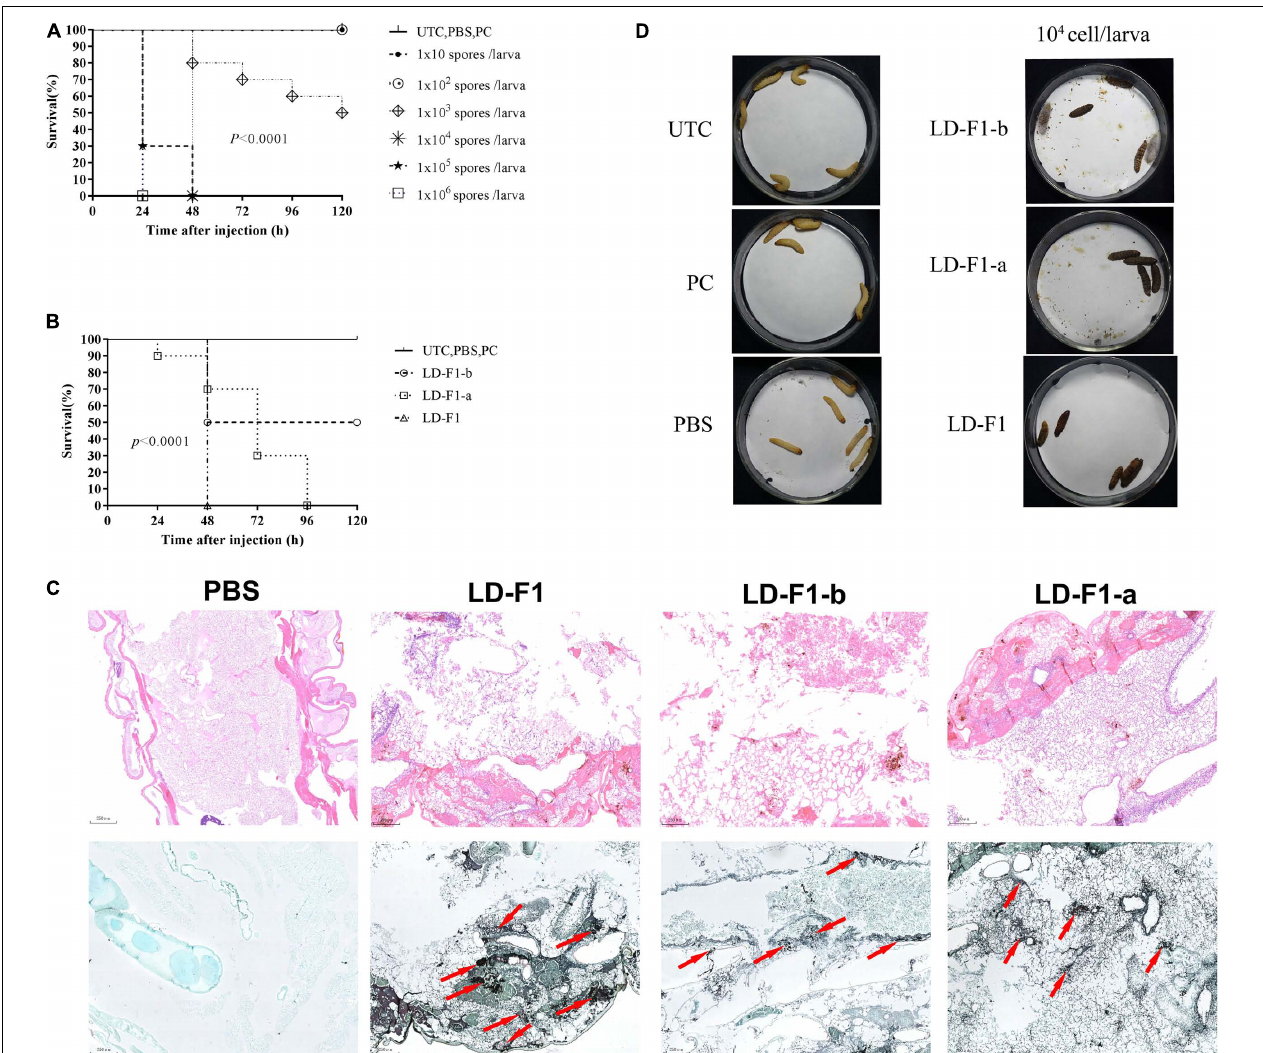
FIGURE 6 | (A) Determination of the optimal spore concentration of A. flavus for pathogenicity testing in G. mellonella. The G. mellonella larvae were injected with spores of A. flavus isolate LD-F1 using 10, 10 2 , 10 3 , 10 4 , 10 5 , and 10 6 spores per larva. (B) Survival of G. mellonella larvae infected with 10 5 spores/larva of virus-free isolate (LD-F1), AfPV1-infected isolate (LD-F1-b), and AfPV1- and SatRNA-infected isolate (LD-F1-a) over a 120 h incubation period. (C) Histological observation at 48 h post-inoculation among tissues infected with the virus-free isolate (LD-F1), AfPV1-infected isolate (LD-F1-b), and AfPV1- and SatRNA-infected isolate (LD-F1-a), and the HE staining is on top, while the GMS staining is below, and the red arrows indicate hyphae growth. (D) Melanization of larvae infected with the virus-free isolate (LD-F1), AfPV1-infected isolate (LD-F1-b), and AfPV1- and SatRNA-infected isolate (LD-F1-a). Control experiments are comprised of non-treated larvae (UTC), pierced larvae (PC), and PBS-injected larvae (PBS). P -values were estimated using Log rank